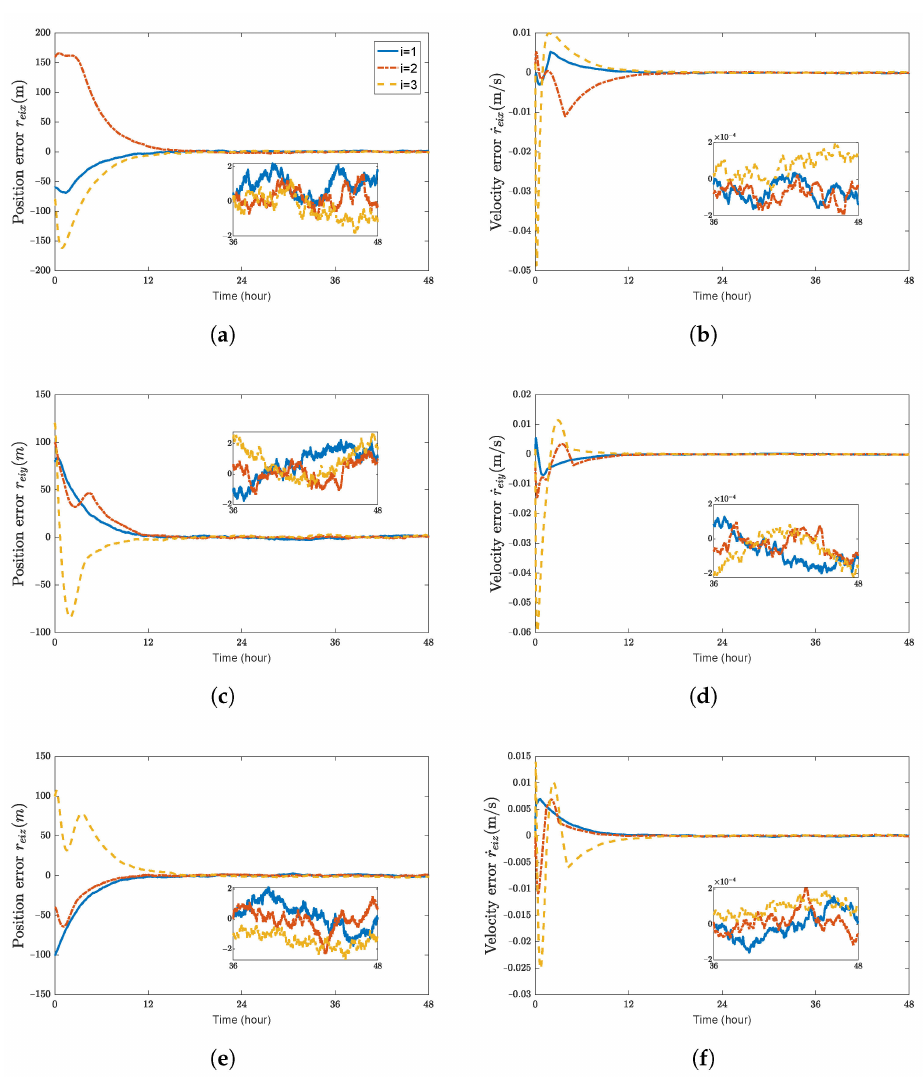
Figure 4. Position errors and velocity errors of spacecraft SC1 ∼ 3 with adaptive control law. ( a ) position error r eix (m); ( b ) velocity error ˙ r eix (m/s); ( c ) position error r eiy (m); ( d ) velocity er- ror ˙ r eiy (m/s); ( e ) position error r eiz (m); ( f ) velocity error ˙ r eiz